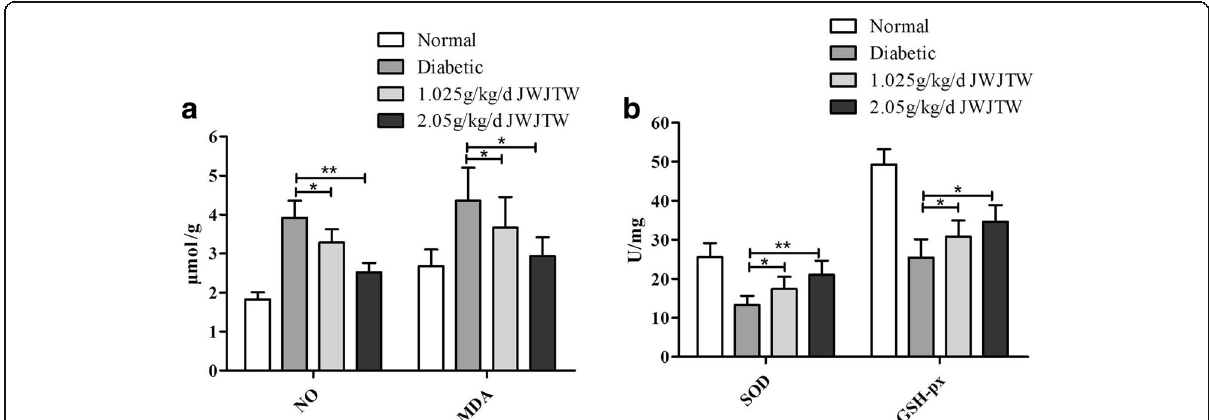
Fig. 5 Effects of JWJTW on SOD and GSH-px activity, MDA and NO content of pancreatic islets in diabetic rats. NO: nitric oxide, SOD: superoxide